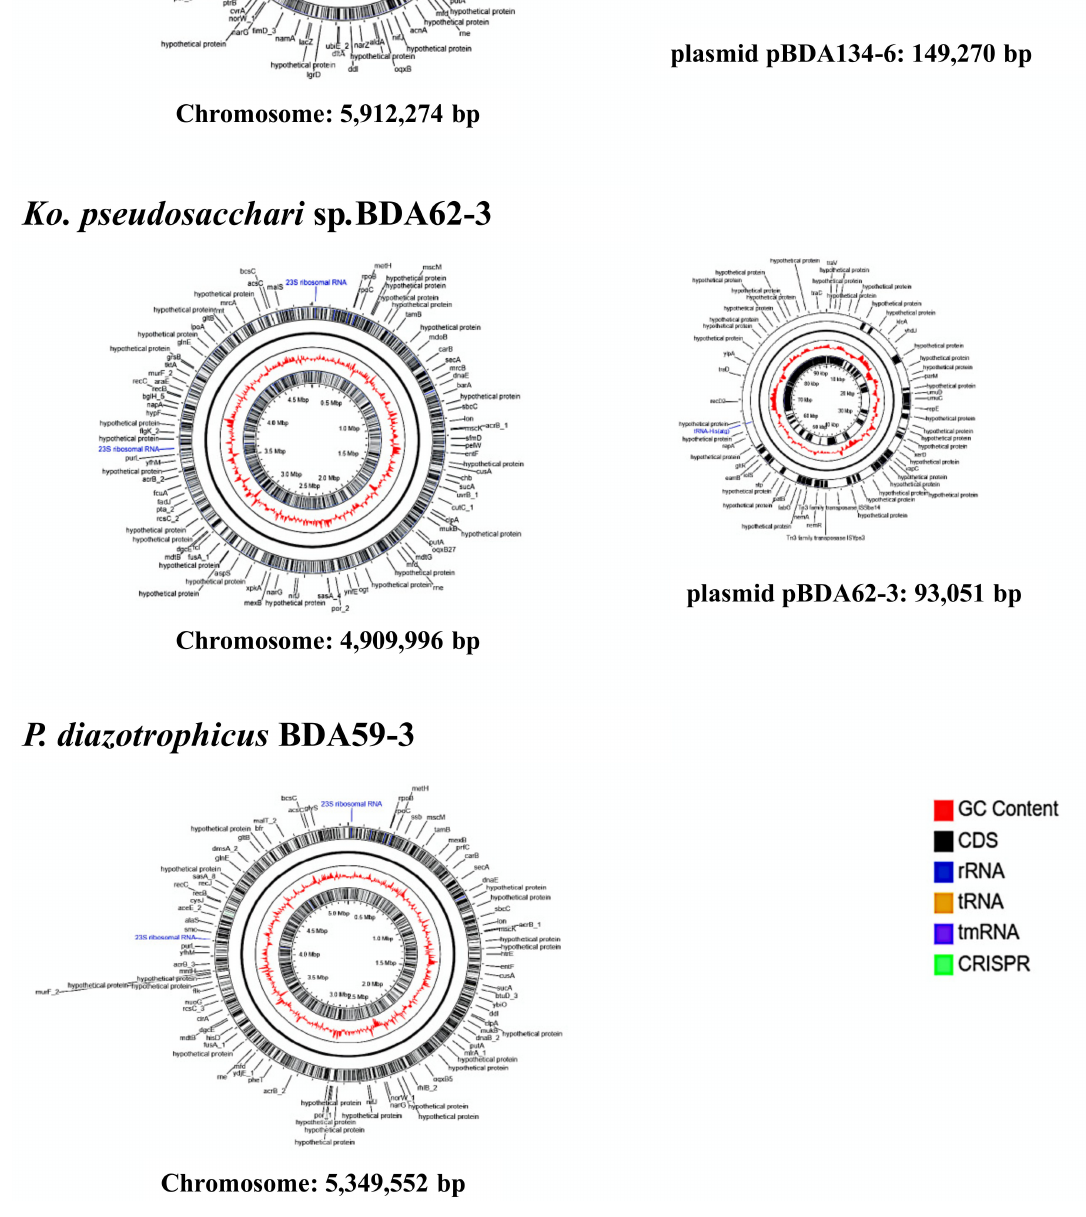
Figure 2. Circular maps of the genomes of Kl. pasteurii BDA134-6, Ko pseudosacchari BDA62-3 and P. diazotrophicus BDA59- 3 showing the inner GC content and annotation. Maps were obtained from the CGView Server (http://cgview.ca/, https://doi.org/10.1093/bib/bbx081, accessed on 1 April